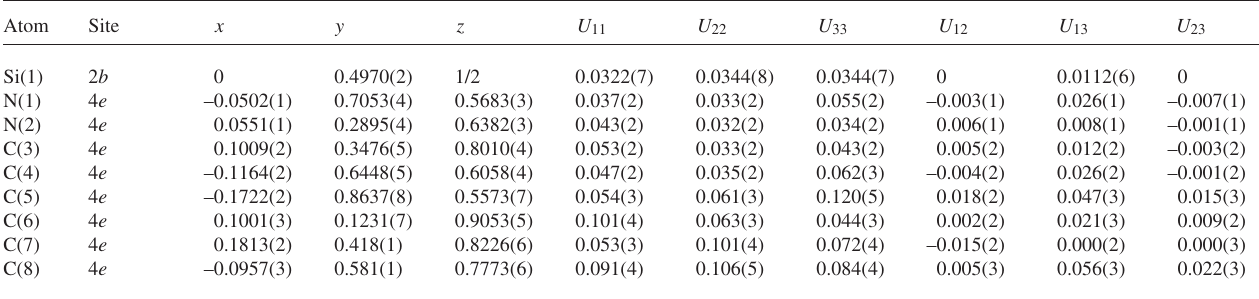
Table 3. Atomic coordinates and displacement parameters (in Å 2 )